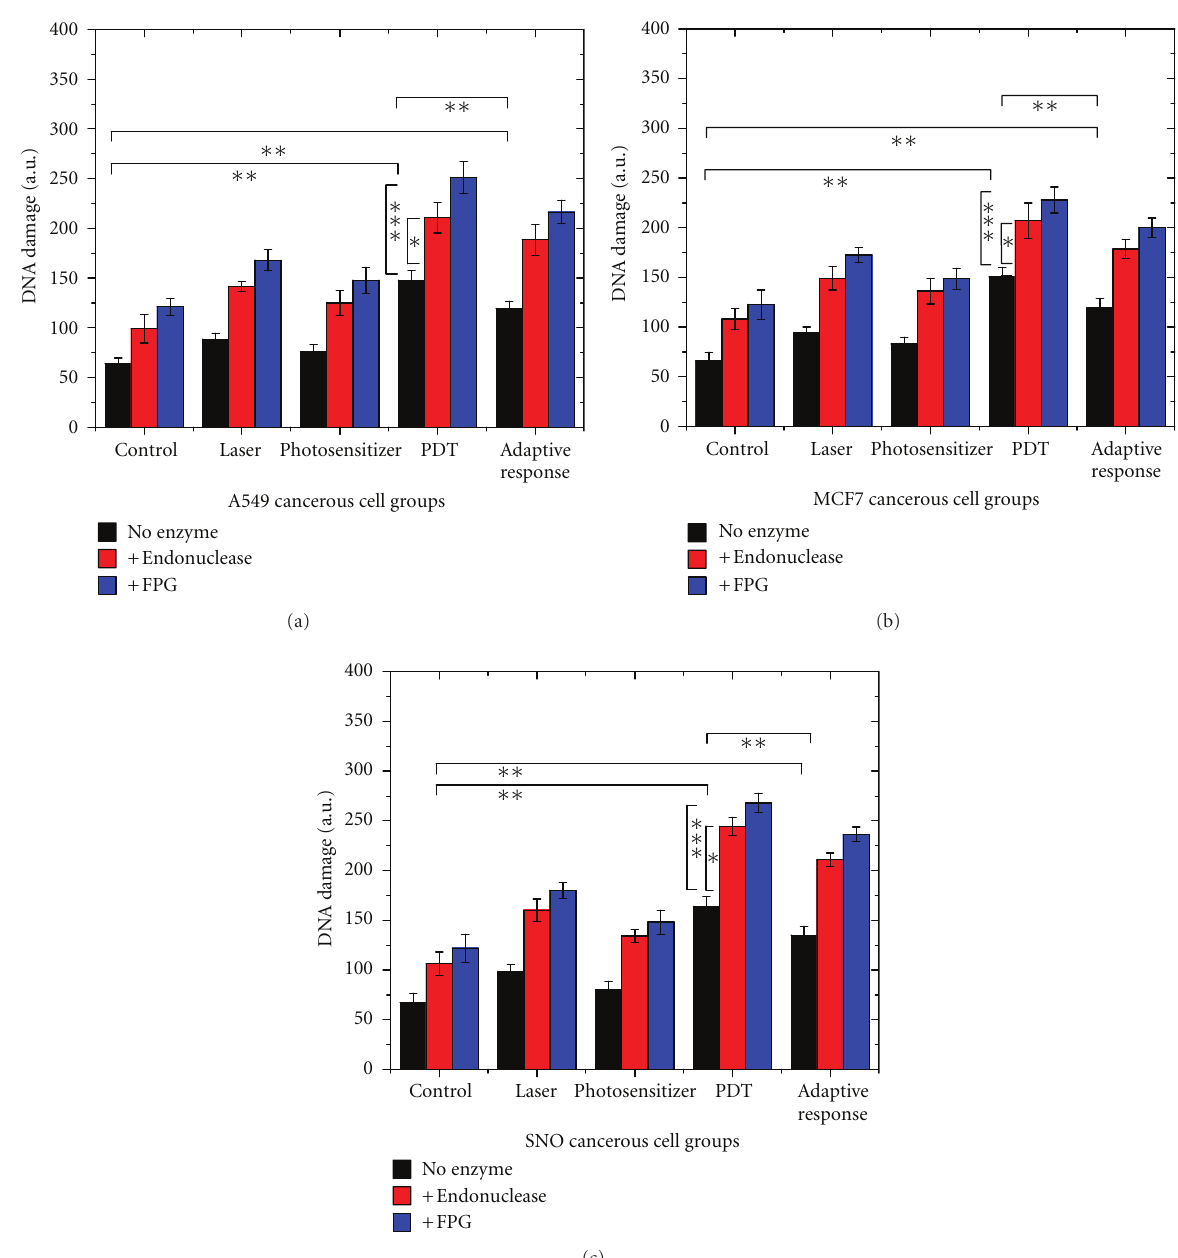
Figure 4: Comet assay measuring the DNA damage without using any enzyme, with using Endonuclease III and FPG protein for the five ex- perimental groups of (a) A549, (b) MCF7, and (c) SNO cancer cells. In all three cell types the cells showed significant DNA damage after PDT treatment while cells that were pre-sensitized displayed less DNA damage compared to the PDT-treated cells. The sensitivity of the comet assay is enhanced significantly by using Endonuclease II and FPG proteins ( ∗∗∗ P < 0 . 001; ∗∗ P < 0 . 05; ∗ P < 0 .